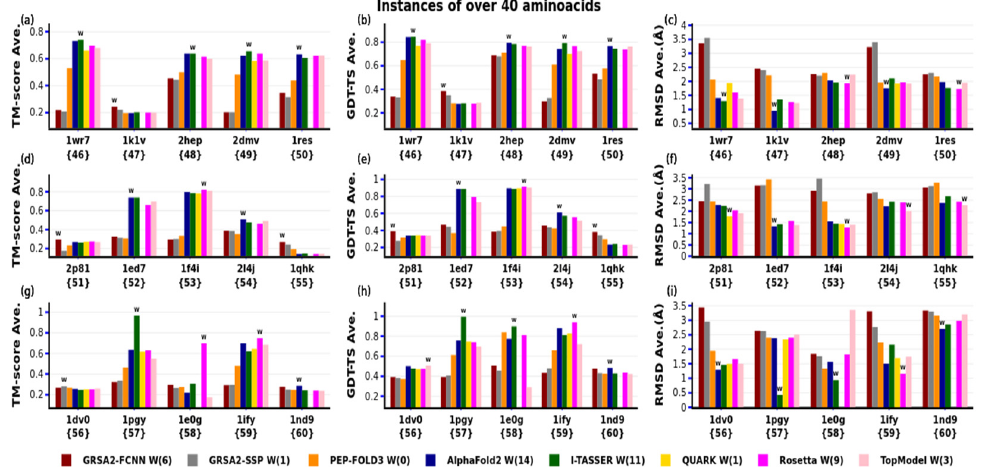
Figure 9. Comparison of GRSA2-FCNN versus I-TASSER, AlphaFold2, Rosetta, QUARK, PEP-FOLD3, TopModel, and GRSA2-SSP (over 40 aa). ( a , d , g ) show the average of the five best predictions of TM-score. ( b , e , h ) present the GDT-TS metric; and ( c , f , i ) show the RMSD results.